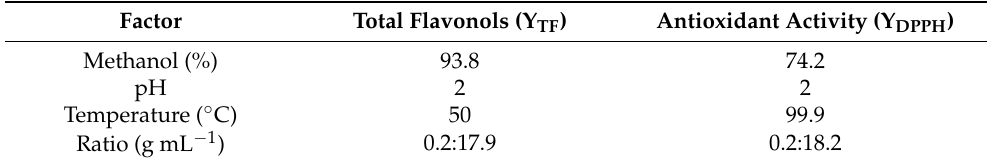
Table 5. Optimal conditions for individual